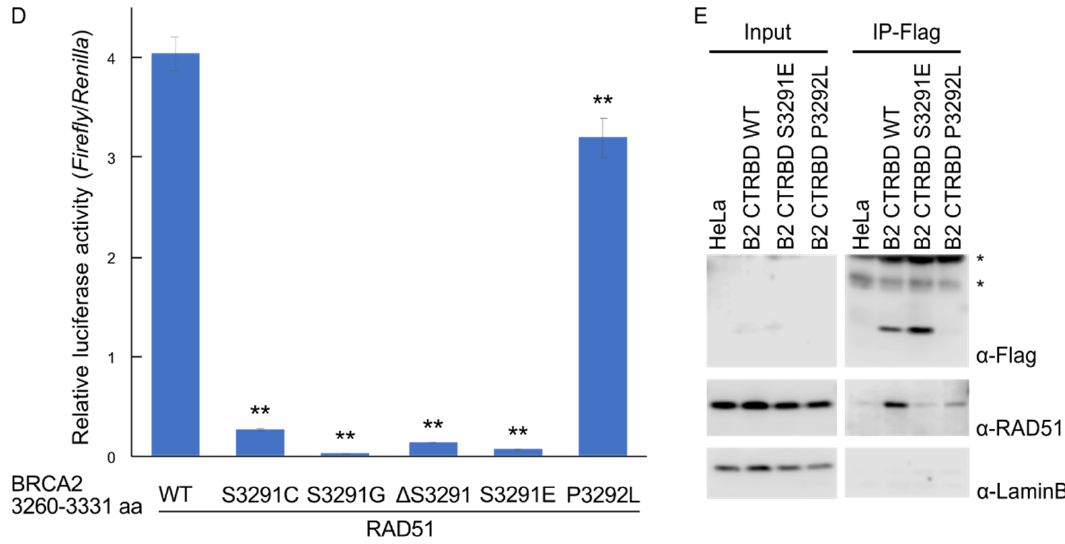
Figure 1. RAD51 interaction of the BRCA2 C-terminal RAD51-binding domain (CTRBD). ( A ) Sche- Figure matic of the BRCA2 protein and its CTRBD. BRCA2 has two major sites to interact with RAD51: the BRC repeats and the C-terminal RAD51-binding region. Three nuclear localization signals and two phosphorylation sites (S3291 and T3387) are also indicated. ( B ) The interaction of RAD51 with the wild-type BRCA2 C-terminus (3260–3418 aa) and its phosphorylation-mimicking (T3387D and T3387E) and phosphorylation-eliminated (T3387A) mutants was assessed using coimmunoprecipi- tation. Lysates from these BRCA2 C-terminus-expressing HeLa cells were immunoprecipitated with